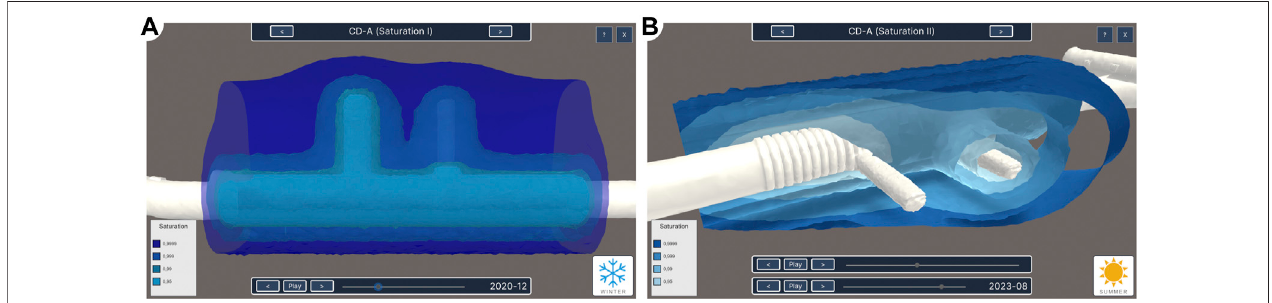
FIGURE8| ThetwotypesofsimulationvisualisationinthescopeoftheCyclicDeformationExperiment (A) thesemi-transparenttop-downviewand (B) theopaque front-side visualisation with an additional slider for the clipping plane. Both types of visualisation include an additional symbol to indicate the current meteorological season at the bottom right. see Zie fl e et al. (2021, 2022) for details.